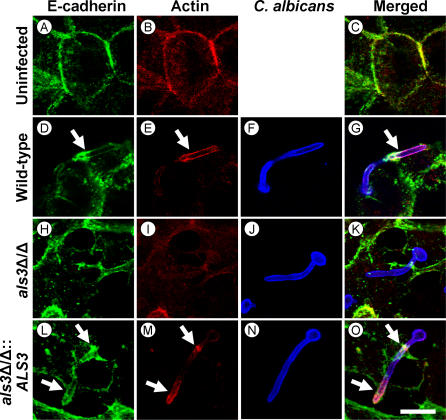
E-Cadherin from Oral Epithelial Cells Colocalizes with Wild-Type C. albicans, but Not an als3Δ/als3Δ Mutant StrainConfocal micrographs of uninfected FaDu oral epithelial cells (A–C) or epithelial cells infected with the wild-type strain (D–G), the als3Δ/als3Δ null mutant (H–K), or the als3Δ/als3Δ::ALS3-complemented strain (L–O). The cells were stained for E-cadherin (A), (D), (H), and (L), microfilaments (B), (E), (I), and (M), and C. albicans (F), (J), and (N). The merged images are shown in (C), (G), (K), and (O). Arrows indicate the accumulation of E-cadherin and microfilaments around the organisms. Bar in (O) indicates 10 μm.